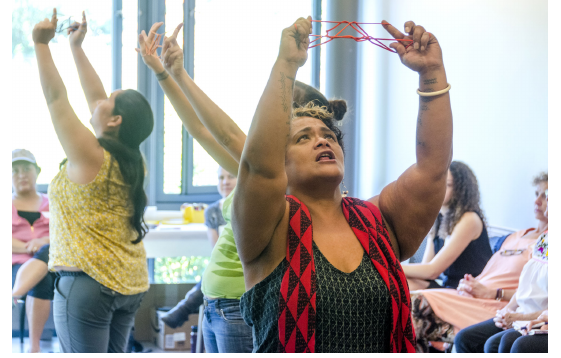
Fig. 5 . Kukmu Kekuhi and H ā lau ʻŌ hi ʻ a learners from Hilo, Hawai ʻ i demonstrate the hei (string images that illustrate songs and stories) for the mele